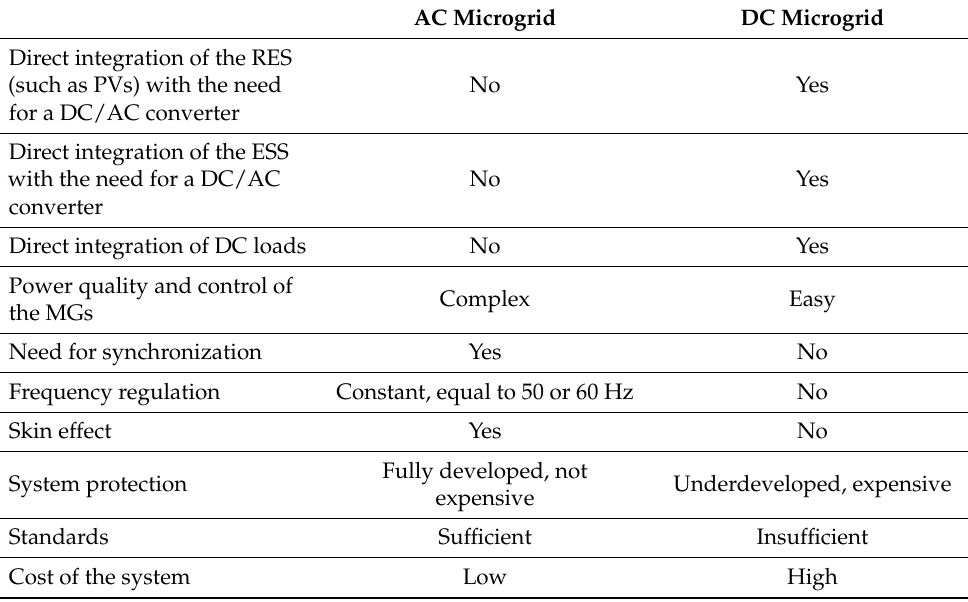
Table 3. Summary of the advantages and disadvantages of AC and DC microgrids. AC Microgrid